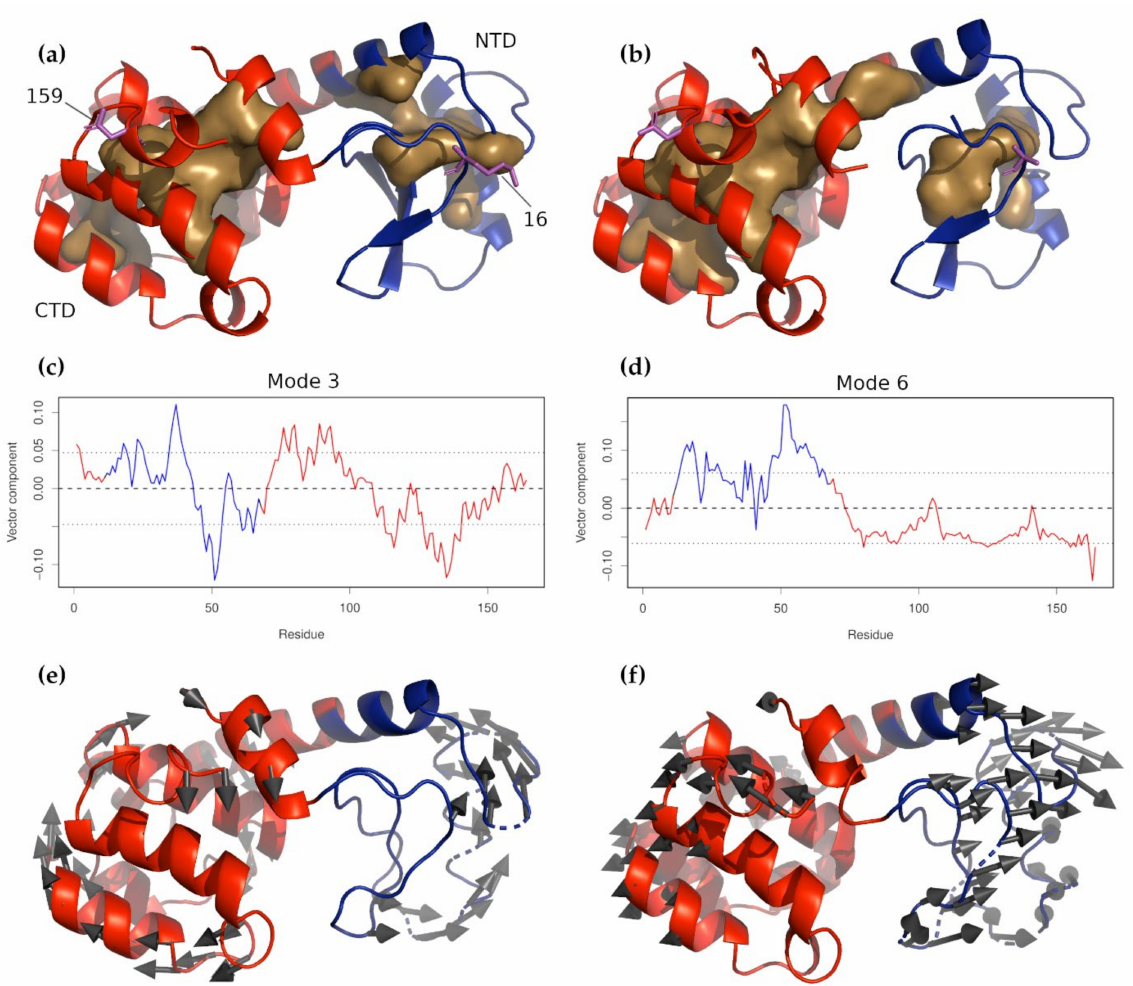
Figure 2. T4 Lysozyme and circularly permuted mutant CP13. ( a ) Wild-type T4 lysozyme and ( b ) CP13. In both panels, the N-terminal domain is colored blue, and the C-terminal domain is red. The buried cores of each domain are indicated by the light brown surfaces. Residues 16 and 159, where the molecule was tethered for the force experiments, are shown in magenta sticks. The z -components of non-zero normal modes 3 and 6 for wild-type T4 are shown in panels ( c , d ), respectively, with the residues corresponding to the NTD and CTD colored as in panels ( a , b ). The dashed line near 0.00 indicates the mean displacement. It can be seen, especially for mode 6, that the two domains moved in opposite directions in these modes, meaning that they were likely to be amplified by the applied force. The characteristic motions of these two modes are shown in panels ( e , f ) below their respective z -component plots (mode 3 in ( e ) and mode 6 in ( f